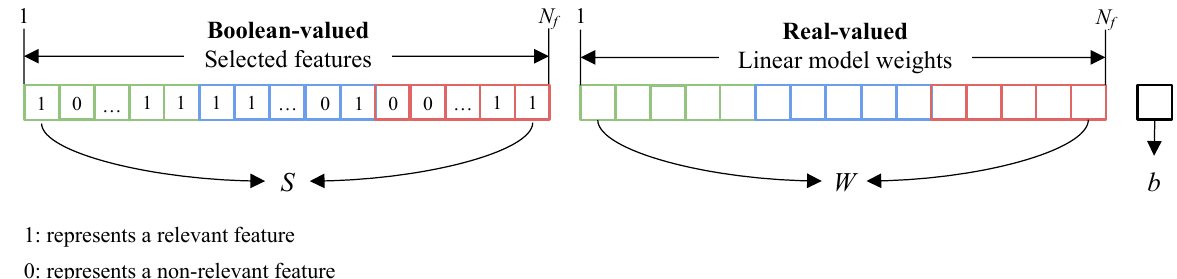
Figure 6. Mixed-coded chromosome used for mapping deep features into an aesthetic prediction. It consists of a Boolean- valued part, S , for feature selection, W where the elements are encoded by real-valued representation, and b is the bias. S and W have a number of elements corresponding to N f , namely the number of